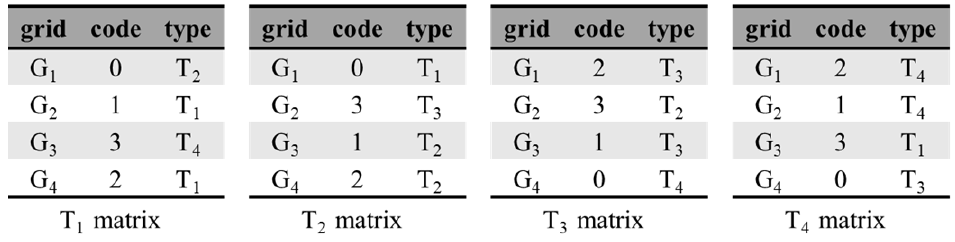
Figure 7. Transition matrixes for Hilbert curves.